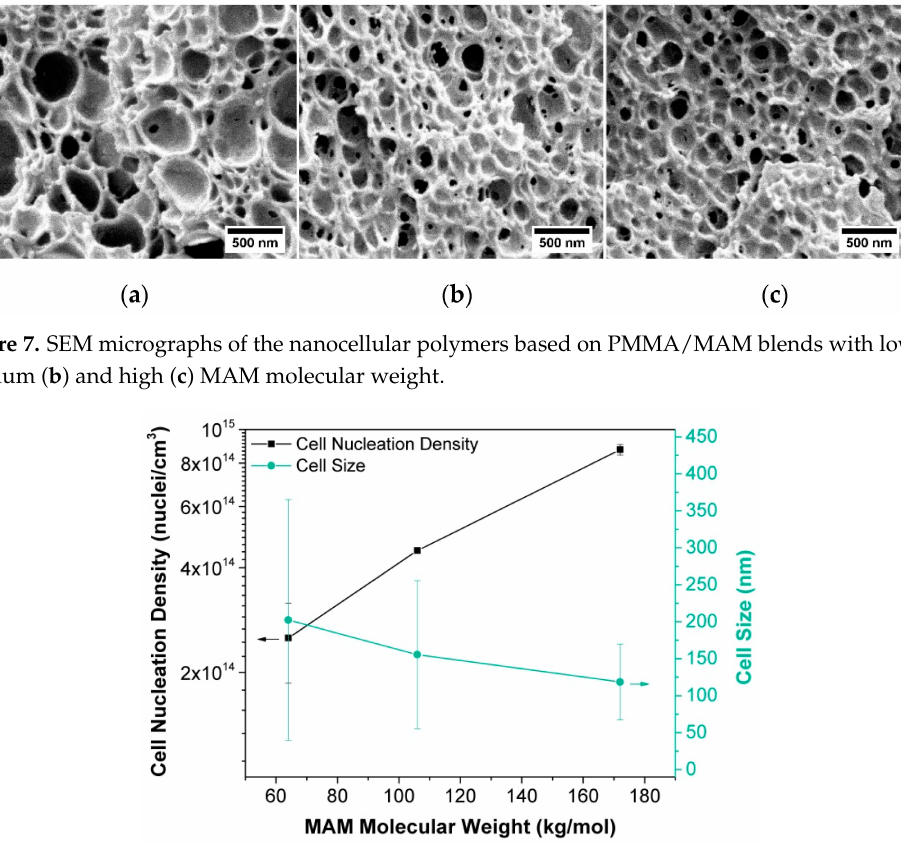
Figure 8. Cell nucleation density (left axis) and cell size (right axis) of PMMA/MAM blends as a function of the MAM molecular